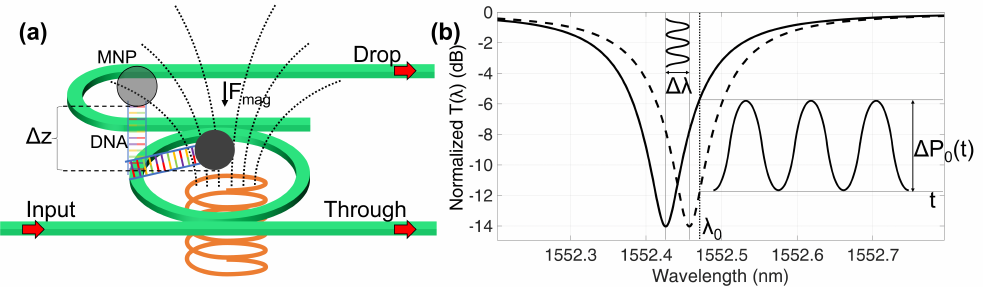
Figure 1. Opto − Magnetic dynamic labelling concept. ( a ) The MNP is subject to a magnetic force that produces a vertical dislocation of the biomolecule from the rest position; a varying external magnetic field causes the analyte oscillation. ( b ) The periodic phase perturbation shifts the transfer function T ( λ ) , modulating the output light intensity ∆ P o when a laser has a fixed